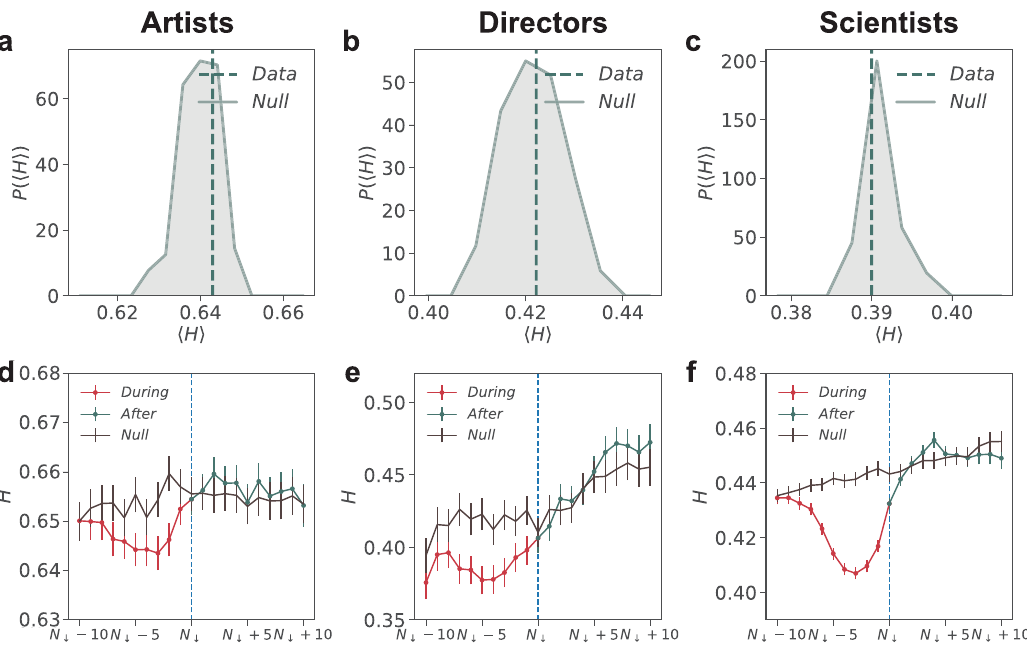
Fig. 5 When hot streak ends. a – c The distribution of entropy P h H ið Þ after a hot streak for 1000 realizations of the randomized careers for all individuals analyzed in our datasets. The vertical line indicates H h i measured in real careers, showing that it is statistically indistinguishable from the randomized careers. d – f The dynamics of entropy H surrounding the end of hot streaks for real and randomized careers, measured through a sliding window of six artworks, fi ve fi lms, or fi ve scienti fi c papers. Error bars represent the standard error of the